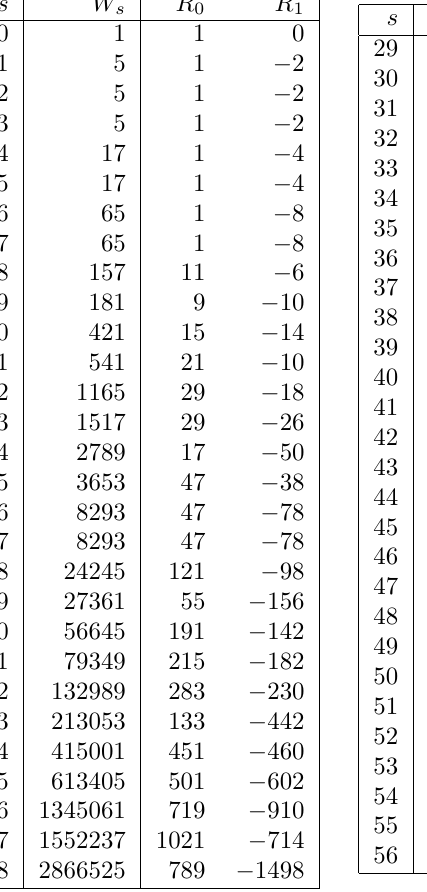
+ R 2 where R 0 is an odd integer, 0 1